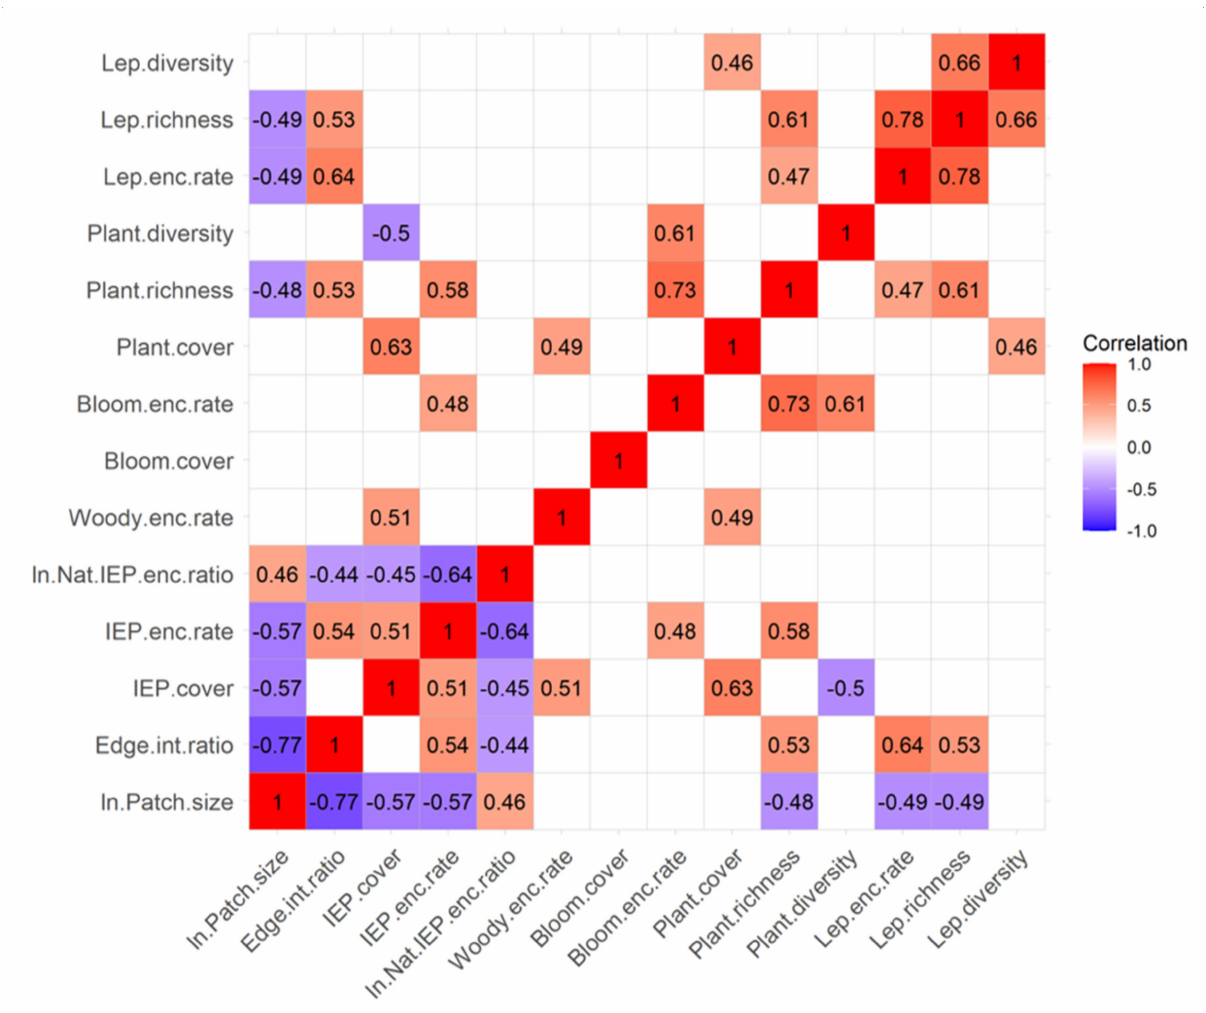
Figure 3. Correlation matrix for 14 key habitat and community attributes. Pearson correlation coefficients are shown for significant correlations ( p < 0.05), and accompanying cells are colored according to the gradient shown in the inset legend. The 14 variables include, in order from left to right and bottom to top: natural log of patch size (ha), edge to interior ratio, IEP plant cover (%), IEP plant encounters per plot, natural log of the ratio of native to IEP plant encounters per plot, woody plant encounters per plot, blooming species cover (%), blooming species encounters per plot, total plant cover (%), plant richness (species per plot), plant diversity ( H (cid:48) ), Lepidoptera encounters per 100 m, Lepidoptera richness (species per 100 m), and Lepidoptera diversity ( H (cid:48)